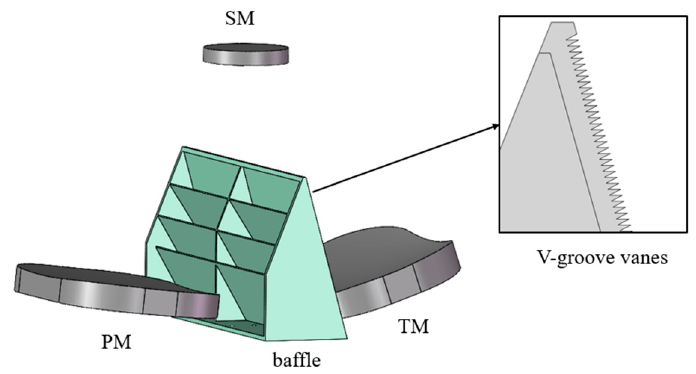
Figure 5. The baffle between PM and TM.